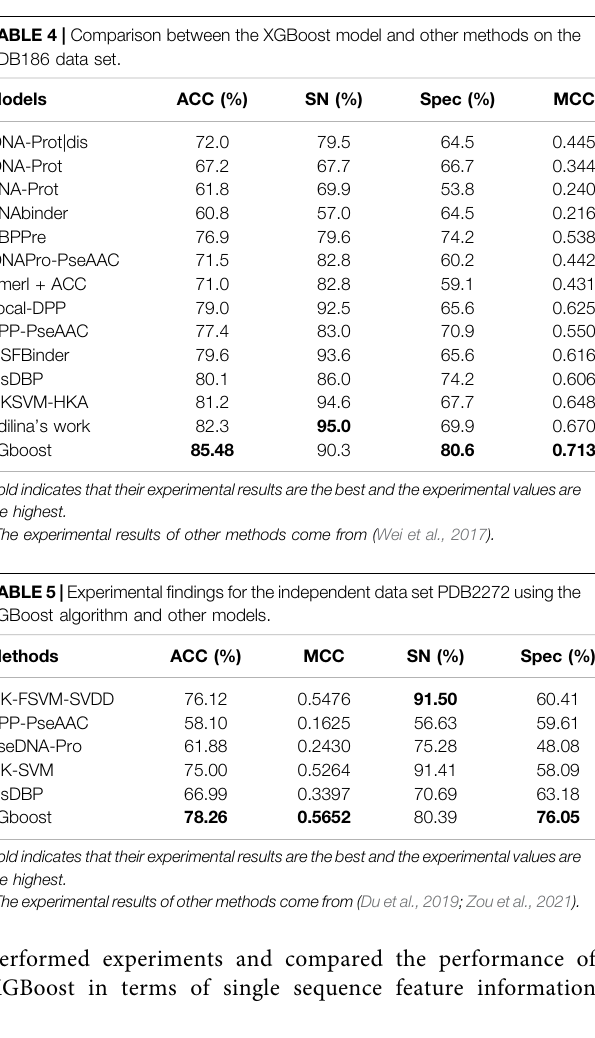
Bold indicates that their experimental results are the best and the experimental values are the highest.